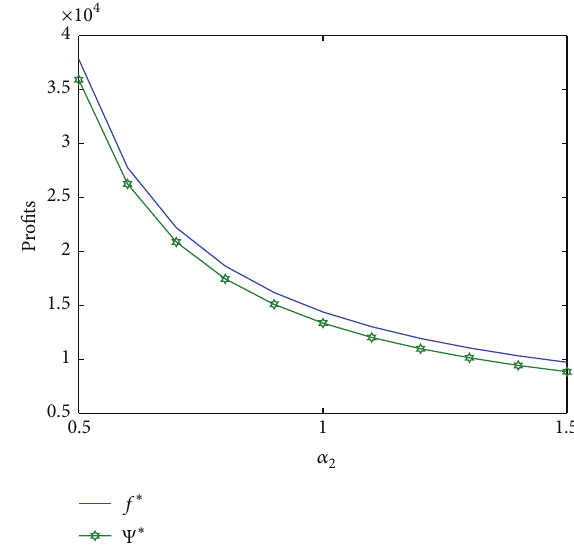
Figure 16: Impact of 𝛼 2 on the profits under demand certainty and